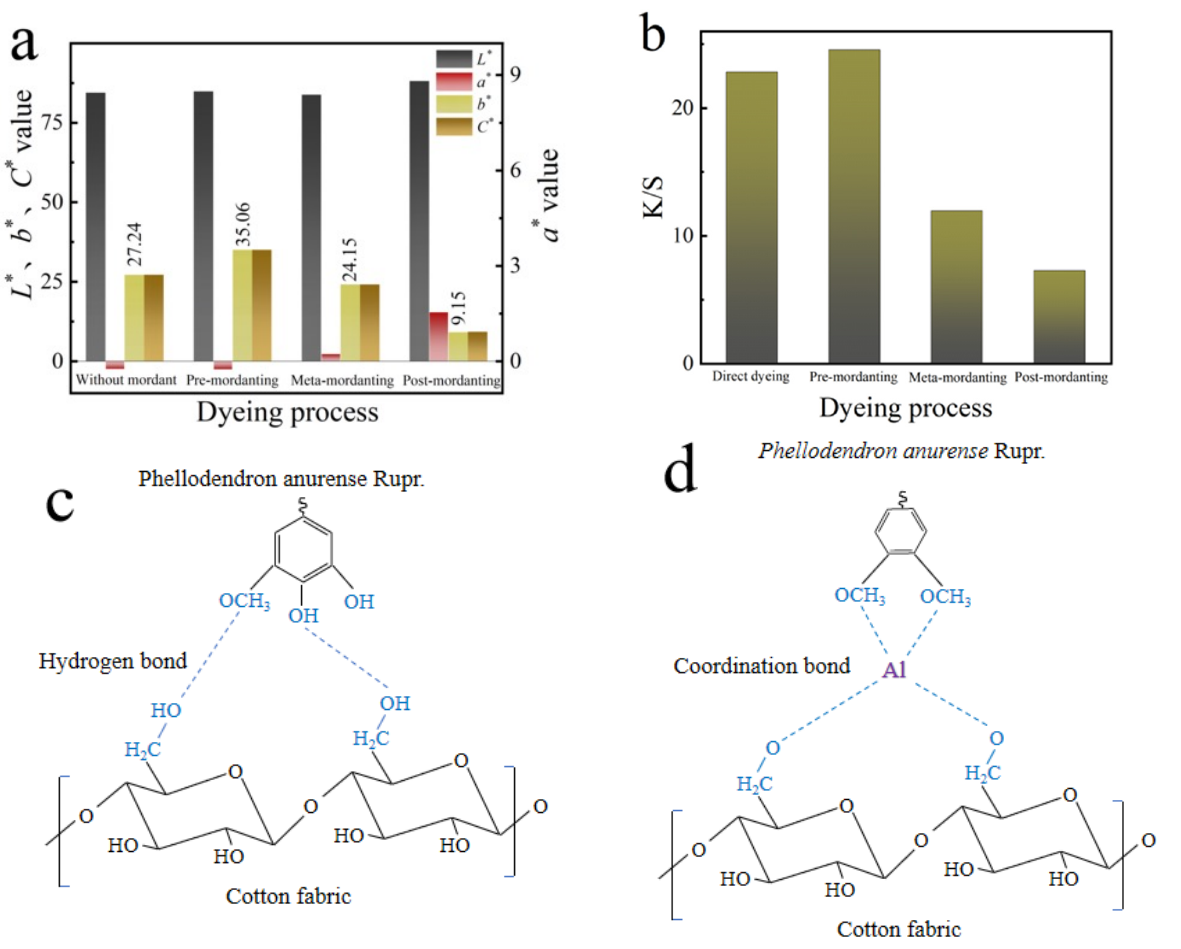
Figure 3. ( a ) Effect of mordanting on the color characteristics of dyed cotton fabrics; ( b ) effect of mordanting on the K/S value of dyed cotton fabrics; ( c ) interaction of P. amurense dye with cotton fabrics; ( d ) interaction of P. amurense dye with Al3+ and cotton fabrics.